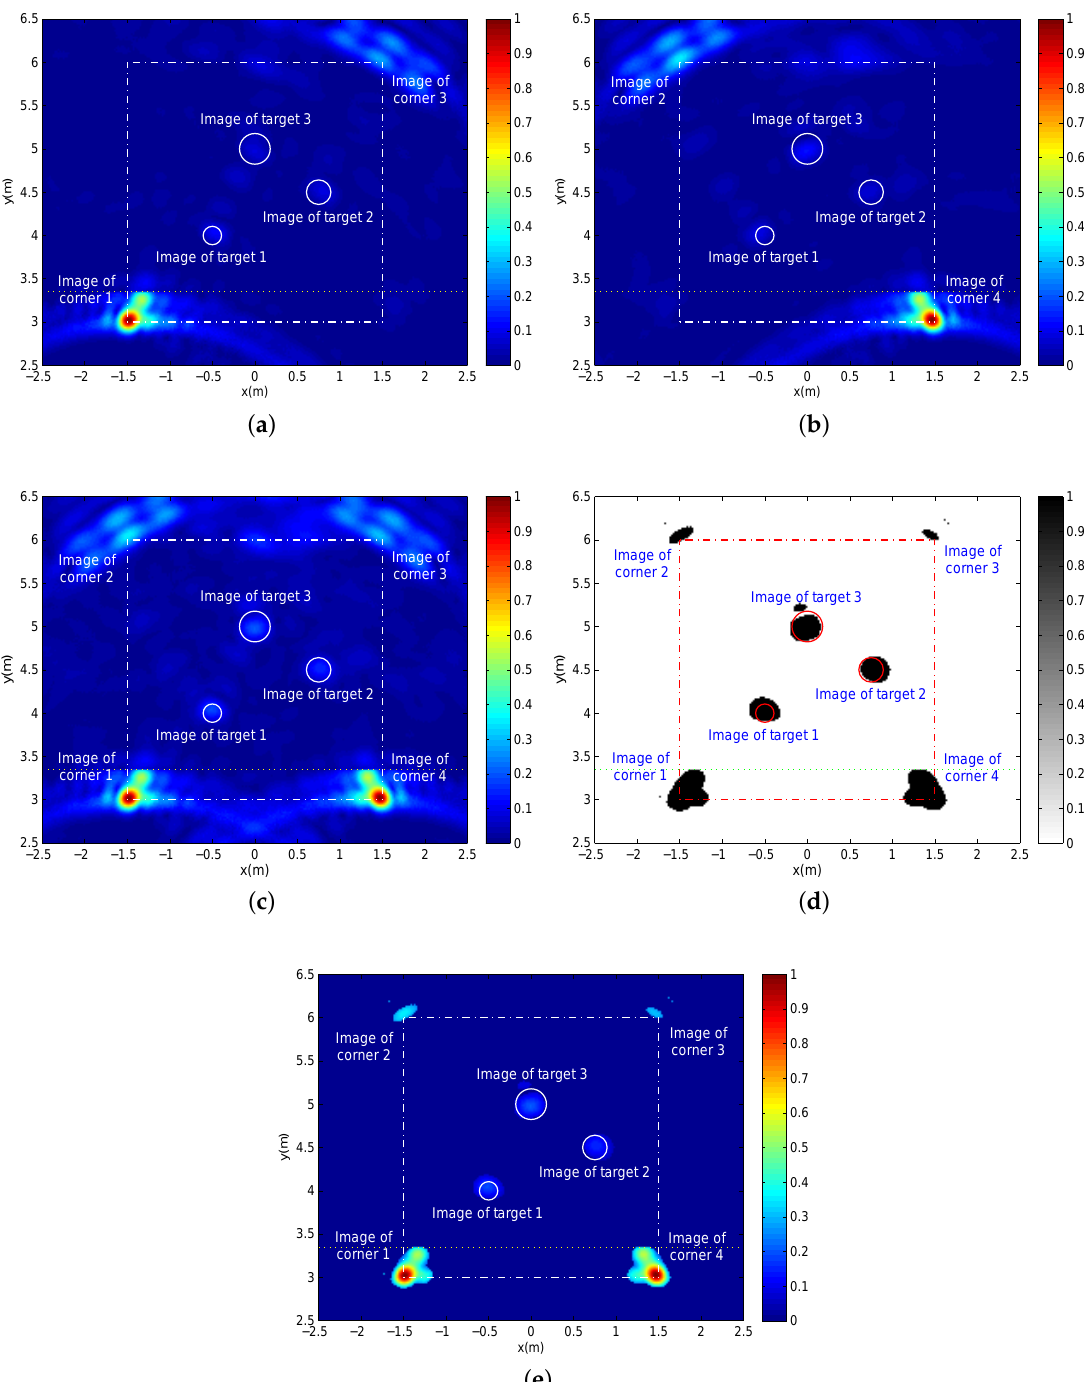
Figure 9. ( a , b ) Two single-location images corresponding to Location A and Location B, respectively; ( c ) The panorama image after additive fusion; ( d ) The binary panorama image after 2D CA-CFAR with P fa = 0.001, 61 × 61 reference window and 37 × 37 protection pixels; ( e ) The panorama image with the original pixel values after 2D CA-CFAR